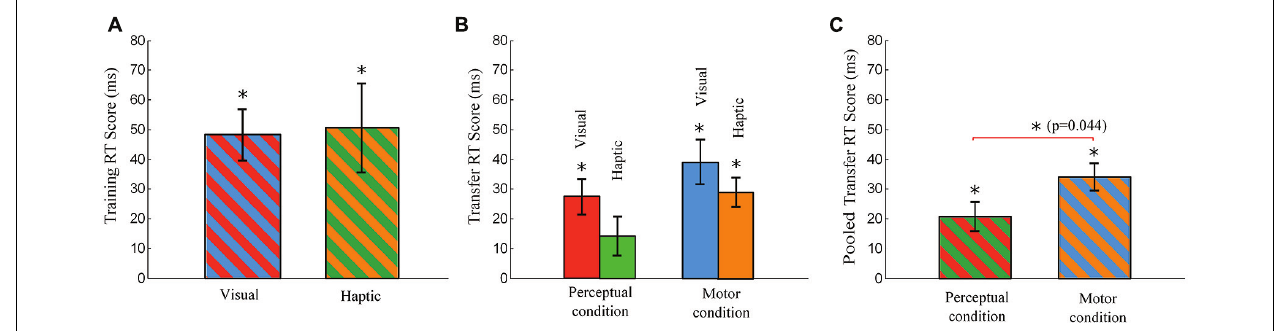
haptic-motor subgroups. (C) Pooled Transfer RT Score (averaged across the visual and haptic groups) in each condition. The motor group shows a significantly greater pooled Transfer RT Score than the perceptual group (ANOVA, p = 0.044). Error bars are ± 1 standard error of the mean. An asterisk on a line linking bars indicates a significant difference between two groups (subgroups) while an asterisk above a bar indicates a significant difference from zero.